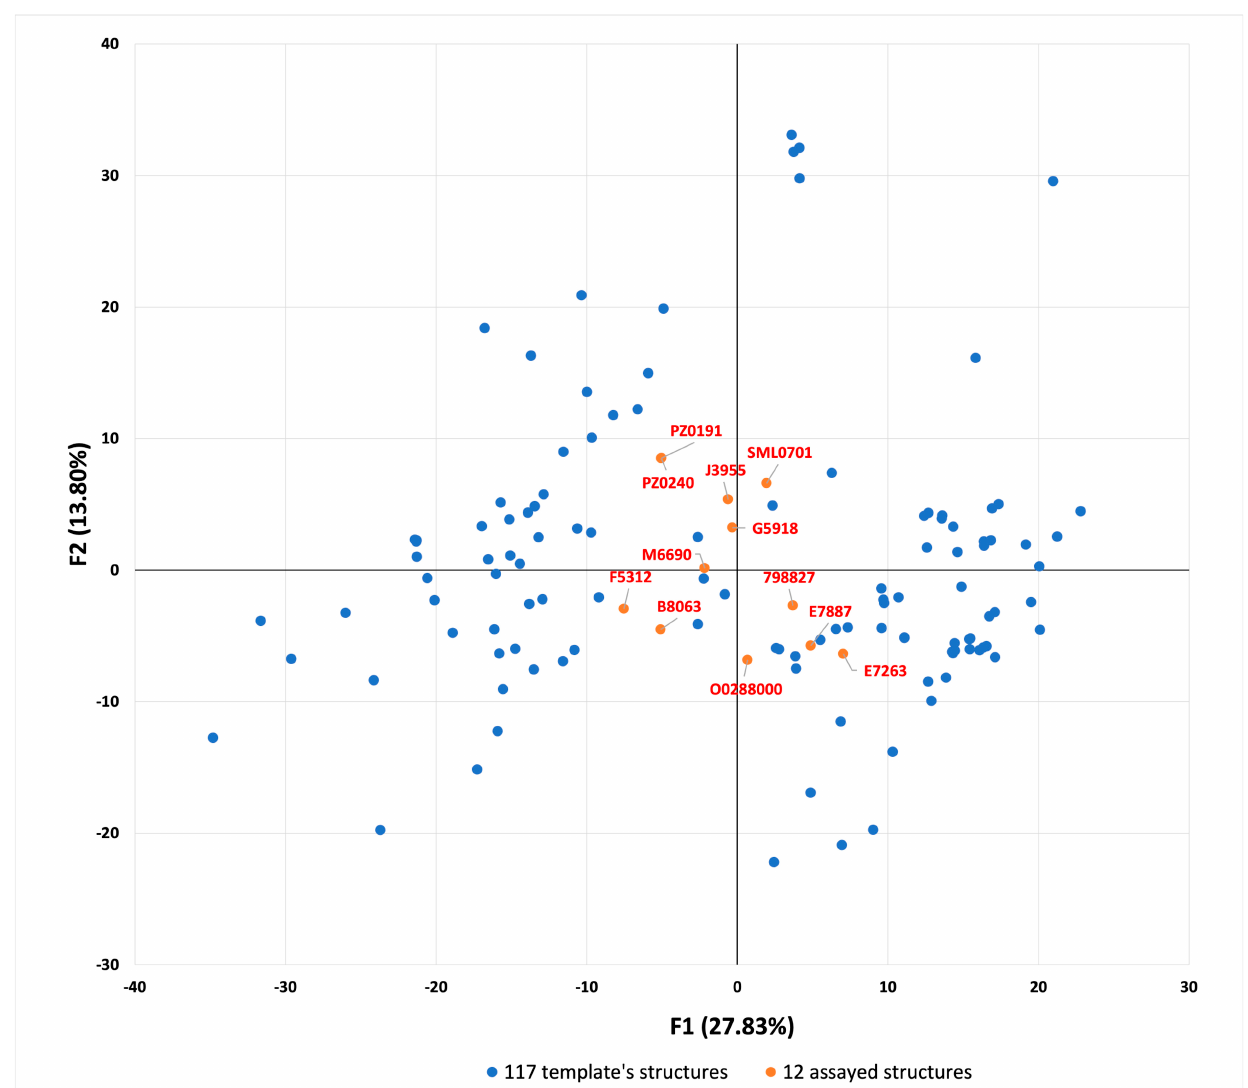
Figure 8. Principal component analysis (F1 versus F2) applied to the molecular descriptor matrix of the selected compounds merged with the known Cdc25